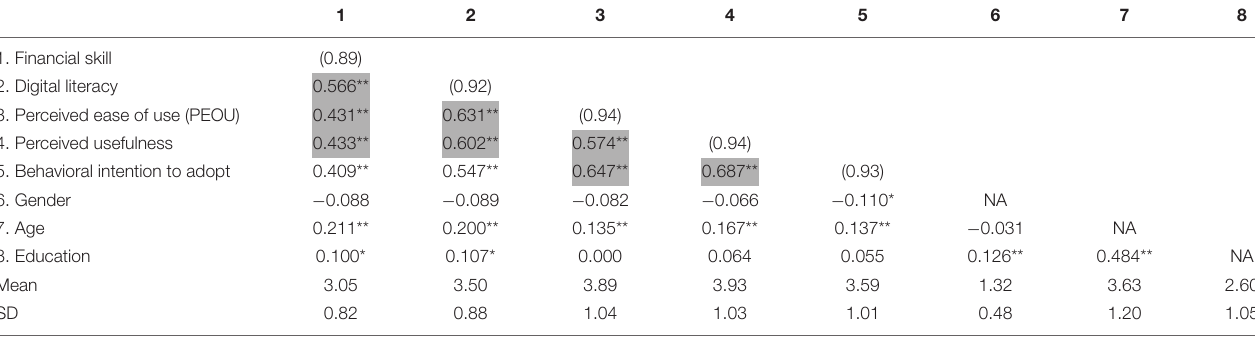
TABLE 1 | Descriptive statistics, internal reliability, and correlation ( r ).